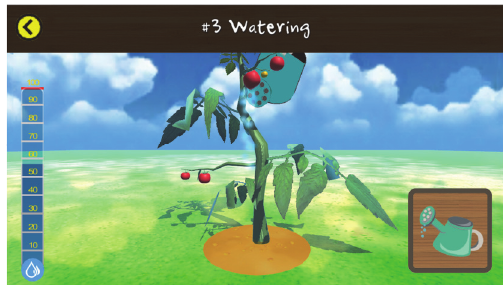
Figure 16: Watering scene. Figure 17: Spraying-pesticide scene.